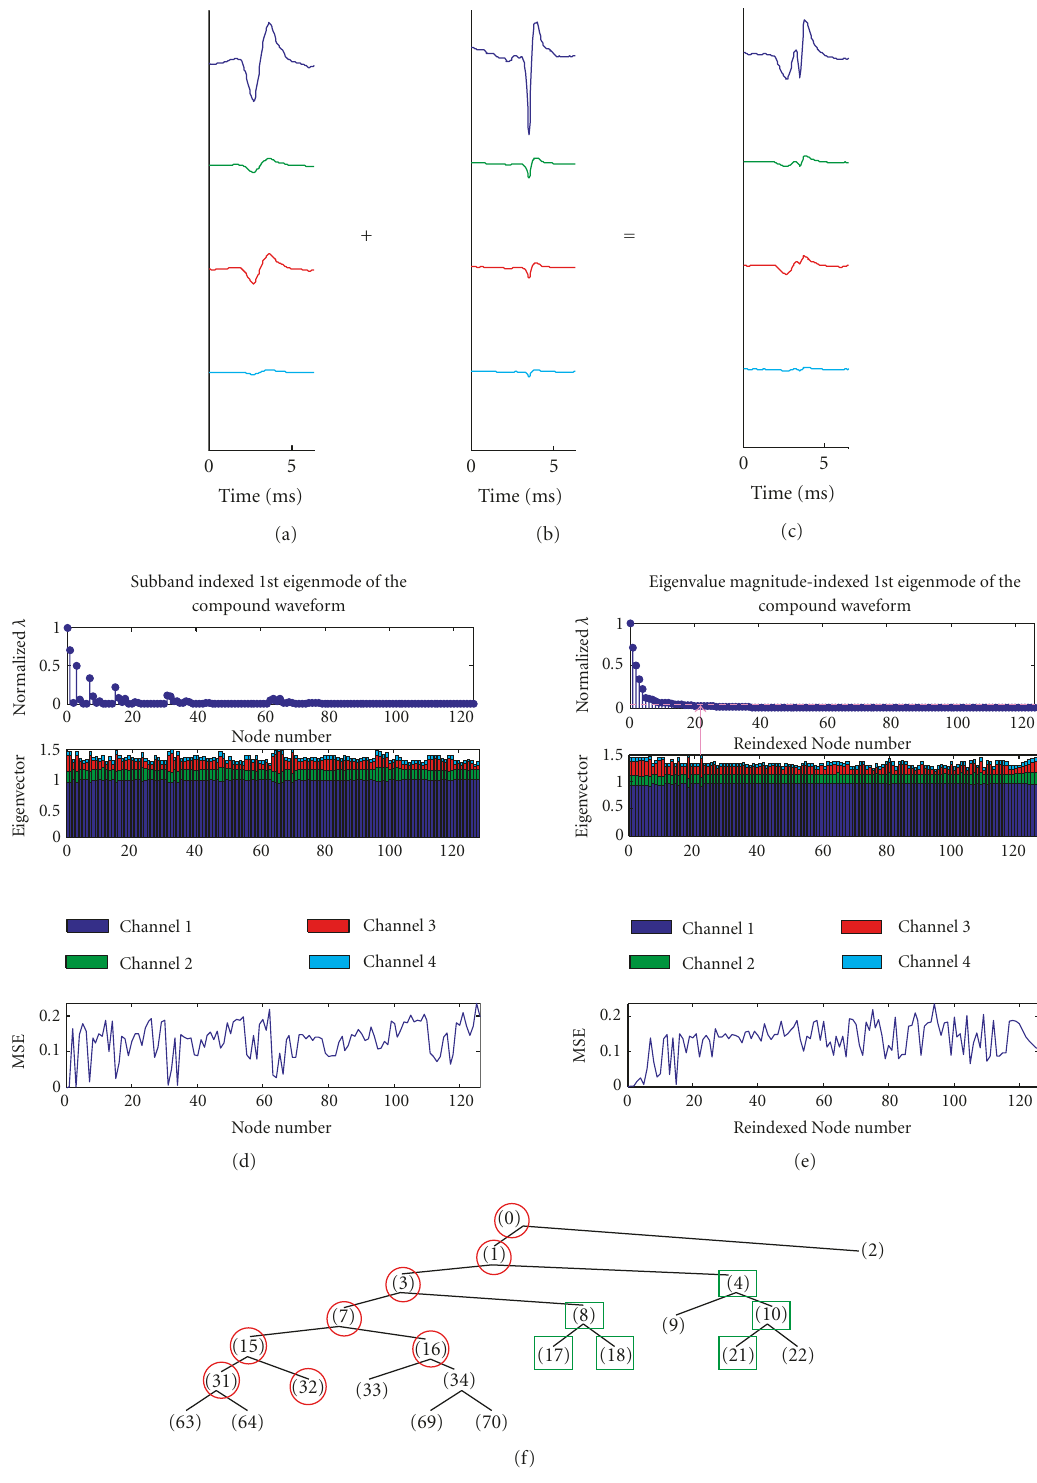
Figure 9: (a), (b) Template sources “ A ” and “ B ” with similar mixing, except for entry a 1 [3] (cid:6)= a 2 [3]. (c) Compound waveform obtained by summing the two normalized signal matrices in (a) and (b). (d) 1st eigenmode of the compound waveform across the DWPT tree. The nonzero eigenvalues correspond to eigenvectors that alternate between sources A and B subspaces. (e) 1st eigenmode of the compound j waveform displayed based on sorting λ 1 in descending order of magnitude. The set of ordered nodes up to node 22 can be seen to contain two subsets, each subset has eigenvectors spanning the subspace of each of the two sources. The MSE in the bottom panel was calculated with respect to a 1 . (f) Best basis binary tree using the first few eigenvalue ordered nodes. Nodes belonging to J A are circled, while those belonging to J B are